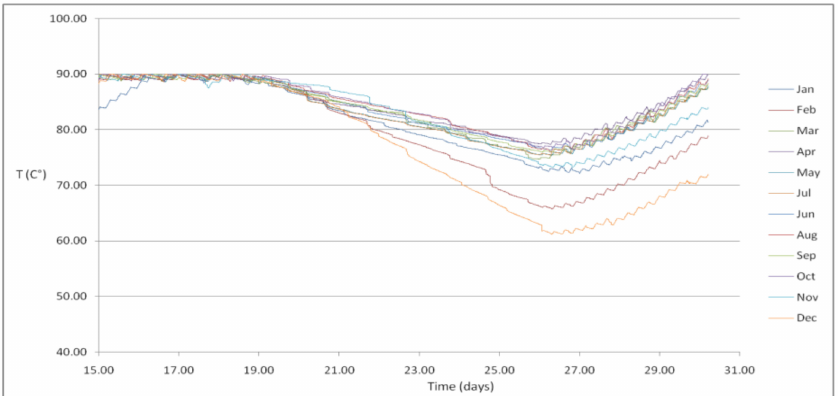
Figure 16. Temperature profiles in the 5 m 3 HWT for the second storage period of every month obtained with outdoor temperatures for the year 2010 (Case